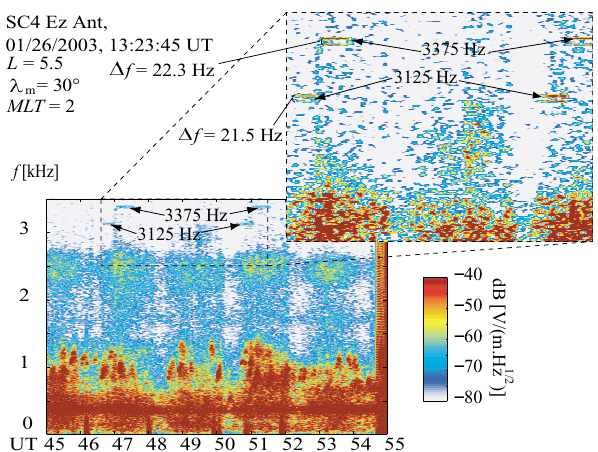
Fig. 9. WBD overview spectrogram from the Cluster satellite pass during 11 May 2003, starting at 05:30:00 UT. The magnitude scale refers to electric field intensity. The time and frequency range in which the HAARP signal was detected during this date is indicated by a dashed-line rectangle. Information about the location of the spacecraft, the L shell, Magnetic Local Time (MLT) the radial dis- tance to the Earth (Re) and magnetic latitude ( λ m ) is shown